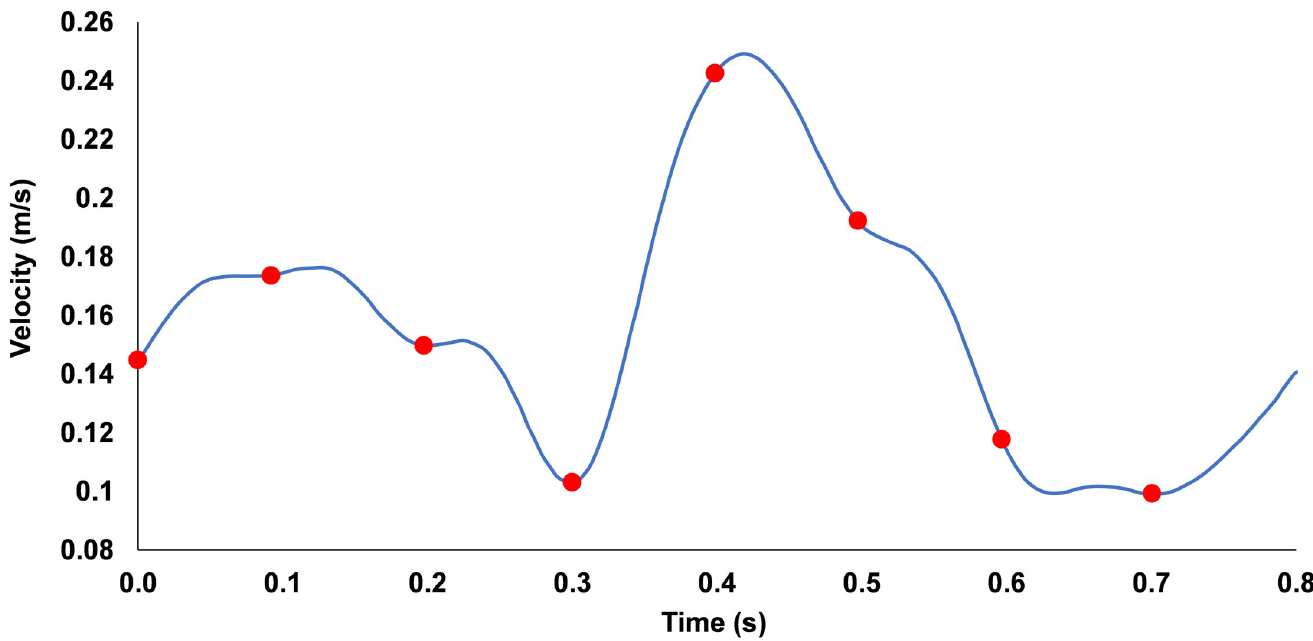
Fig 4. Variation of inlet velocity against time applied to the coronary artery, red dots indicate the 0.1 s intervals during which platelets were released into flow.